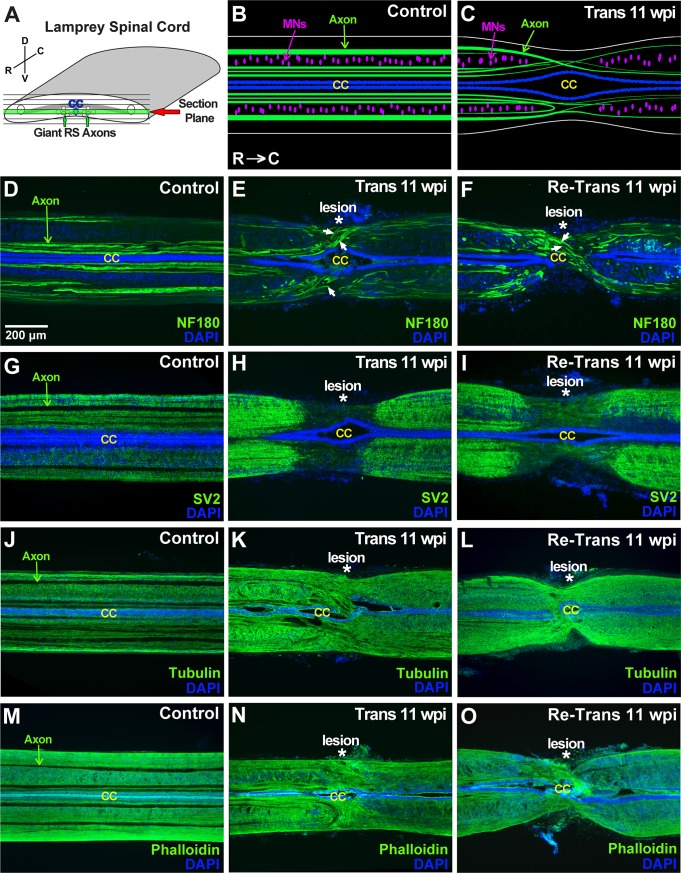
Distributions of axons, synapses, and cytoskeleton are similar at 11 wpi after spinal transection and re-transection.(A) Diagram showing the sectioning strategy and plane of interest. (B-C) Diagrams showing the basic anatomical features of uninjured control and transected (11 wpi) spinal cords. R = rostral; C = caudal. (D-F) NF-180 immunolabeling of control spinal cords shows large RS axons projecting in straight paths; DAPI labeling stains nuclei of ependymal cells that form the central canal (CC) and nuclei of intraspinal neurons. At 11 wpi in both transected and re-transected spinal cords, NF180-labeled axons project in aberrant patterns, and the CC is swollen. Asterisks indicate lesion center. Arrows indicate several regenerating axons crossing through the lesion. (G-I) SV2 immunostaining, which labels synapses, shows a uniform punctate pattern throughout the control spinal cord. After spinal transection and re-transection (11 wpi), SV2 staining is reduced within the lesion site. (J-O) Tubulin and phalloidin staining reveal relatively uniform microtubule and actin distribution, respectively, throughout control, transected and re-transected spinal cords, except in giant RS axons and the CC, which show reduced signal. No obvious differences were observed between transected and re-transected spinal cords. Rostral is to the left in all images. Scale bar in panel D also applies to E-O.